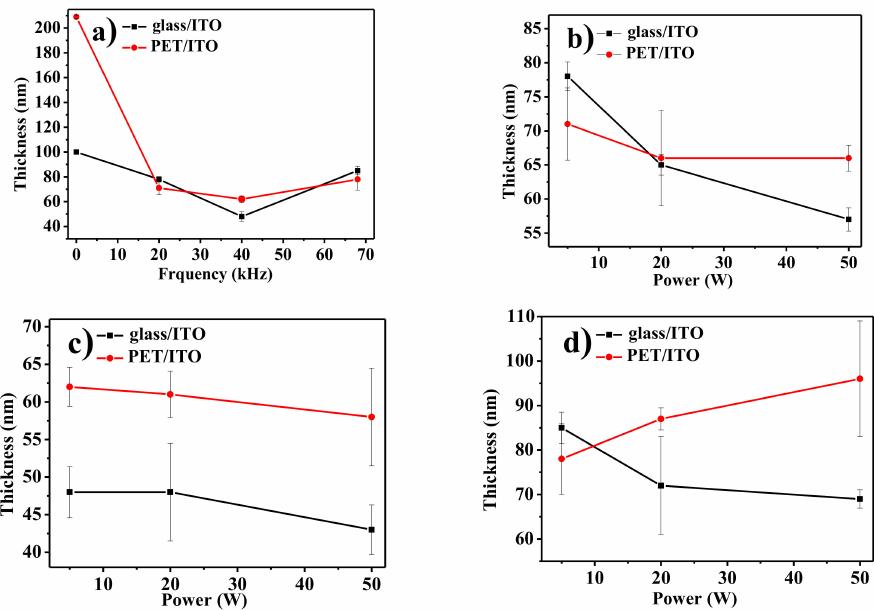
Figure 5. Thickness of PEDOT:PSS coated on glass/ITO and PET/ITO substrates at varying frequencies and powers. ( a ) Thickness versus frequency at 5 W, and thickness versus power at ( b ) 20 kHz, ( c ) 40 kHz, and ( d ) 68 kHz, respectively.